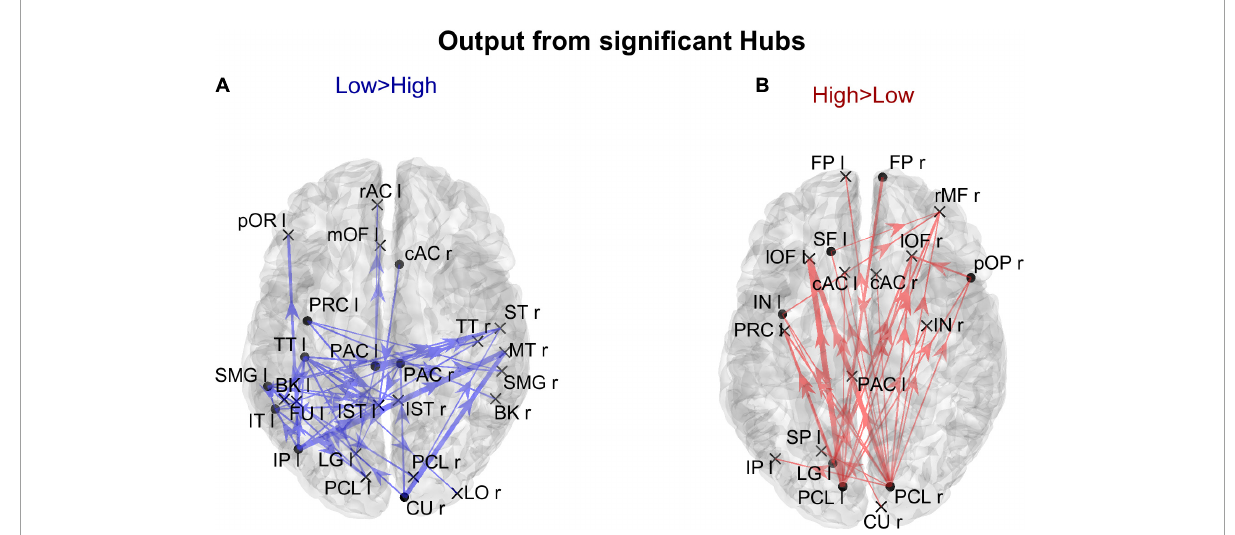
FIGURE9 Representation of the connection differences exiting from the ROIs which exhibited significant differences of hubness between the two groups. The left panel in blue [Low > High (A) ] displays the connection differences exiting from the “Low > High” hubness ROIs (the ROIs shown in the left lower panel in Figure 8 ), for connections higher in the Low compared to the High AQ score Group. The right panel in red [High > Low (B) ] displays the connection differences exiting from the “High > Low” hubness ROIs (the ROIs shown in the right lower panel in Figure 8 ), for connections higher in the High compared to the Low AQ score Group. The plotted connections run from the ROIs with significant hubness (marked with a dot) toward generic input ROIs (marked with a cross). The thickness of each link varies according to the value of the connection difference. Three levels of thickness are adopted, with a higher thickness indicating a larger connectivity